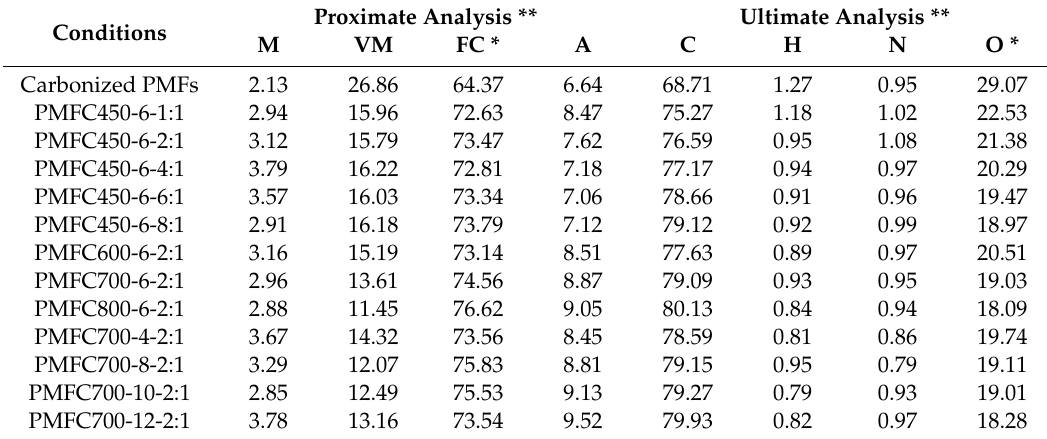
Table 3. Proximate and ultimate analyses of carbonized PMFs and